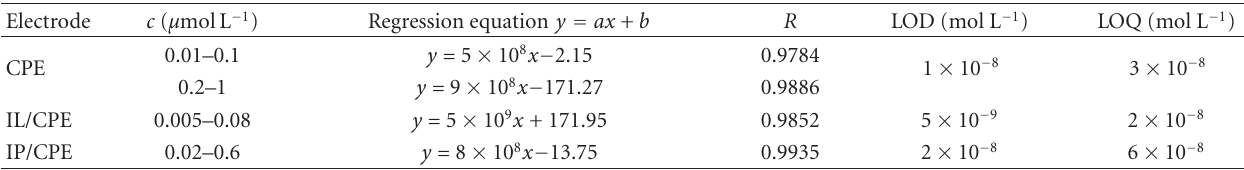
Figure 6: Dependences of DPV peak heights of 2 µ M rutin solution in acetate bu ff er (pH 4.0) at (a) accumulation potential at t acc = 25 s and (b) accumulation time ( E acc = +100 mV). DPV parameters: scan rate 20 mVs − 1 , pulse amplitude 50mV, and pulse width 100ms. Table 2: Parameters of calibration regression straight lines and limits of detection (LOD) and quantification (LOQ) of rutin on the tested carbon paste electrodes, DPAdSV